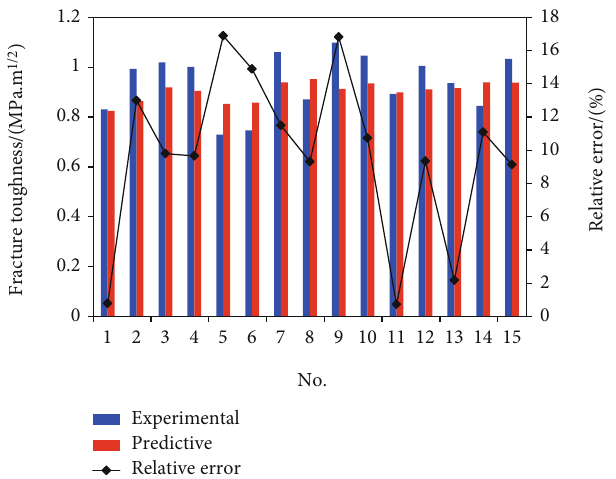
Figure 9: Experimental vs. predictive of fracture toughness of shale average relative error between the prediction values and the Table S1 (in the supporting data), and the results of acoustic measured values of the fracture toughness of shales was testing and fracture toughness testing are listed in Figures 5 9.64%, which was less than 10%. The results suggest that the and 7, respectively. Then, the fracture toughness values of calculation model of the fracture toughness of shales has a those samples are predicted based on the model. As is certain reliability. shown in Figure 9, we can note that the predictable accuracy Generally, it is much easier for shale gas reservoir to be of the prediction model was high, and the predictive values fractured with a higher brittleness index or lower fracture were in excellent agreement with the experimental data. The